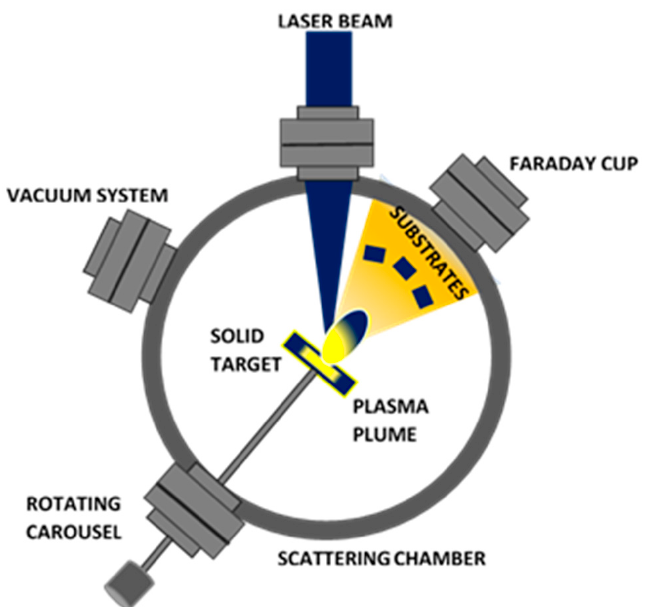
Figure 1. Sketch of the pulsed laser deposition system. In the Laser-induced backward transfer (LIBT) process, a pulsed laser is used to induce the transfer of material from a main target (donor) on a substrate placed close or in contact with the source. The material transfer is in the opposite direction as the laser propagation [10]. Typically, in air, the laser beam passes through the transparent substrate and hits the solid target (donor). At the laser energy threshold, which is higher than the ablation yield, material is ejected from the target and pushed toward the substrate (acceptor). The illustration of the processing is displayed in Figure 2. LIBT was performed at the laser energy of 375 mJ at a 0 ◦ incidence angle from the target surface, with a focused laser beam spot on the solid target of 1 mm in diameter and the laser operating in the repetition rate mode (2.5 Hz) for 5 min. The laser fluence was about 44.8 J/cm 2 . Substrates of polydimethylsiloxane were placed behind the target surface, parallel and at 10 mm from the main target. Both the acceptor and the donor were placed in a stage moved by x-y motors and controlled by a homemade software written in LabView, which proved to be versatile for different laser pulse durations and spot sizes. In our experiment, the laser scans an area of 8 mm × 8 mm along the row directions at a scan resolution of 1 mm and at a velocity of 2